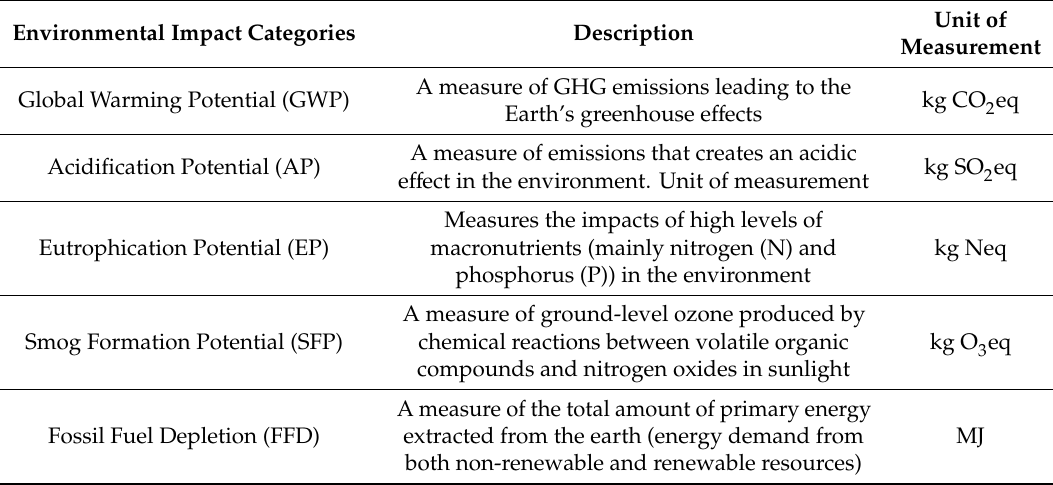
Table 5. Environmental-impact categories